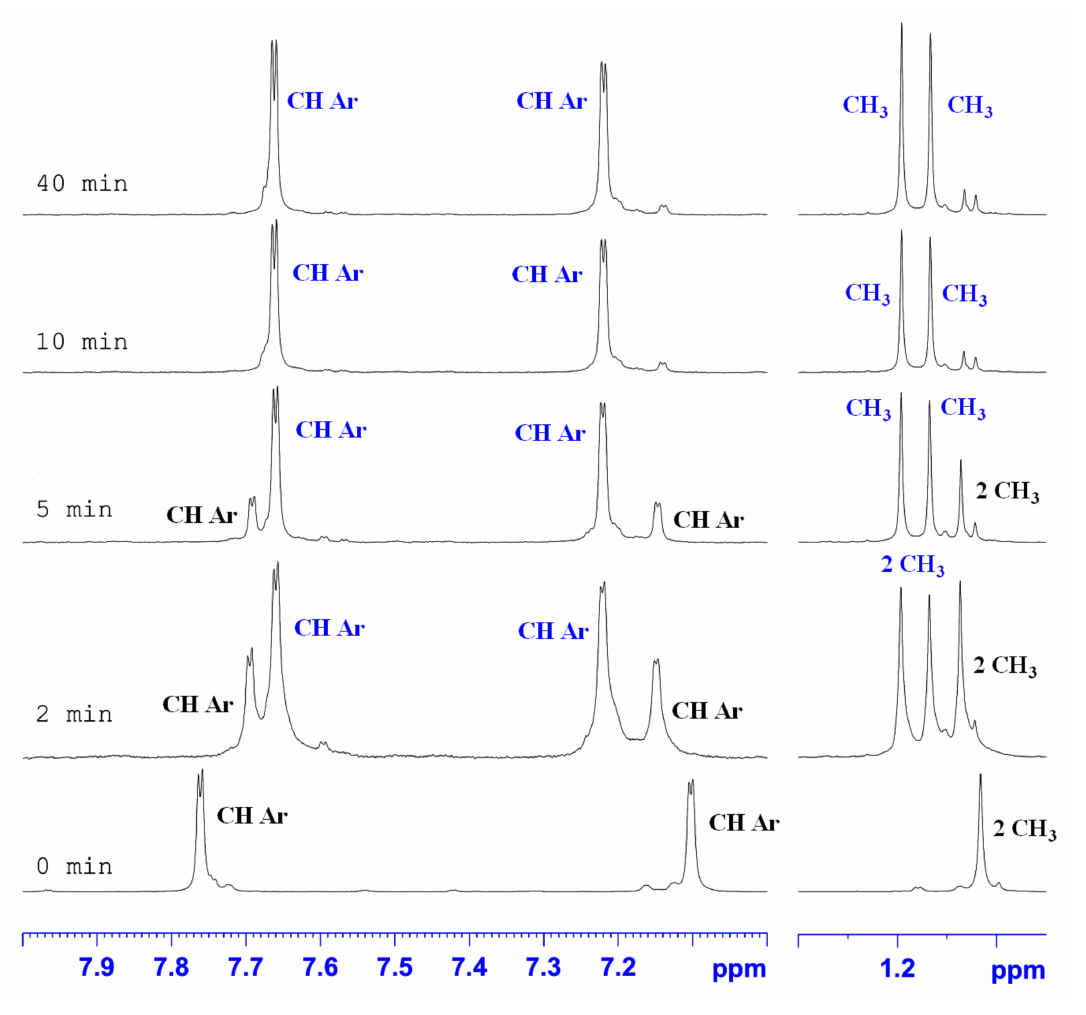
Figure 3. Monitoring of the rearrangement process at 100 ◦ C by 1 H-NMR (for compound 1b ).